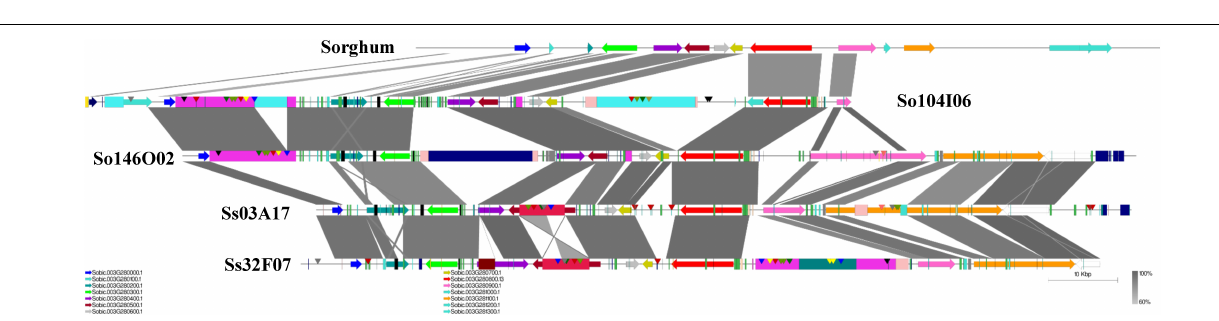
FIGURE 2 | A schematic representation of a syntenic region between Saccharum and sorghum and between S. officinarum and S. spontaneum . The color-coded arrows represent genes, rectangles represent repeats, and conserved domains in transposable elements are represented by pointers. The blast similarity between annotated genic regions is shown by connectors in gray color gradient. A high degree of co-linearity is shared between Saccharum and sorghum and between S. officinarum and S. spontaneum . The large TEs are shared by homologous regions within the same species but not by the ones from different Saccharum